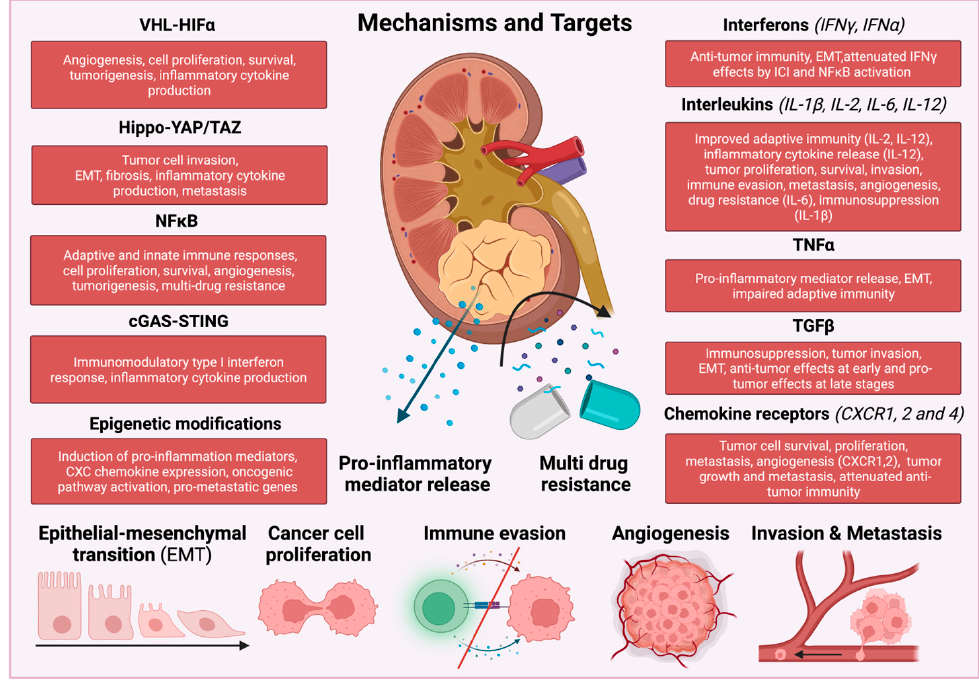
Figure 1. Schematic overview of molecular mechanisms and potential targets of RCC-associated inflammation. Intricate crosstalk between renal cancer cells and TME, regulates pro-inflammatory mediator release, angiogenesis, tumor cell plasticity, survival and proliferation, immune evasion, thereby leading to drug resistance, tumor progression and metastasis.